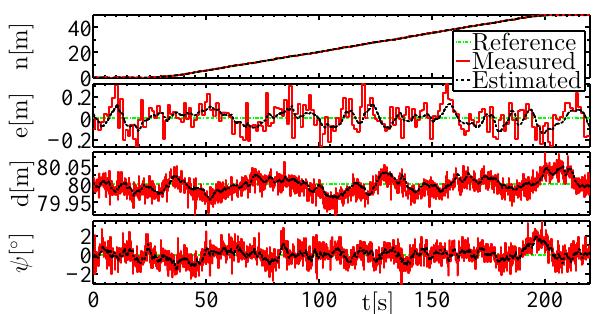
Figure 6: Position and heading (NED frame).